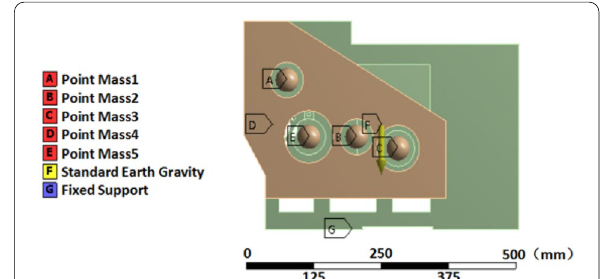
Figure 7 Mass point distribution of gearbox